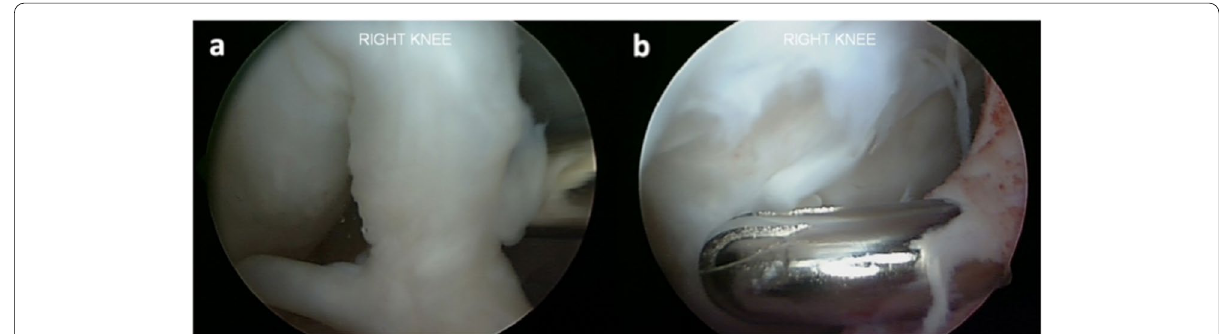
Fig. 3 a Fibrous band tissue over the cartilage repair zone in the medial femoral condyle, 4 mm in thickness. b Chondroplasty was performed, removing the scar tissue from the joint portion using a shaver. 451